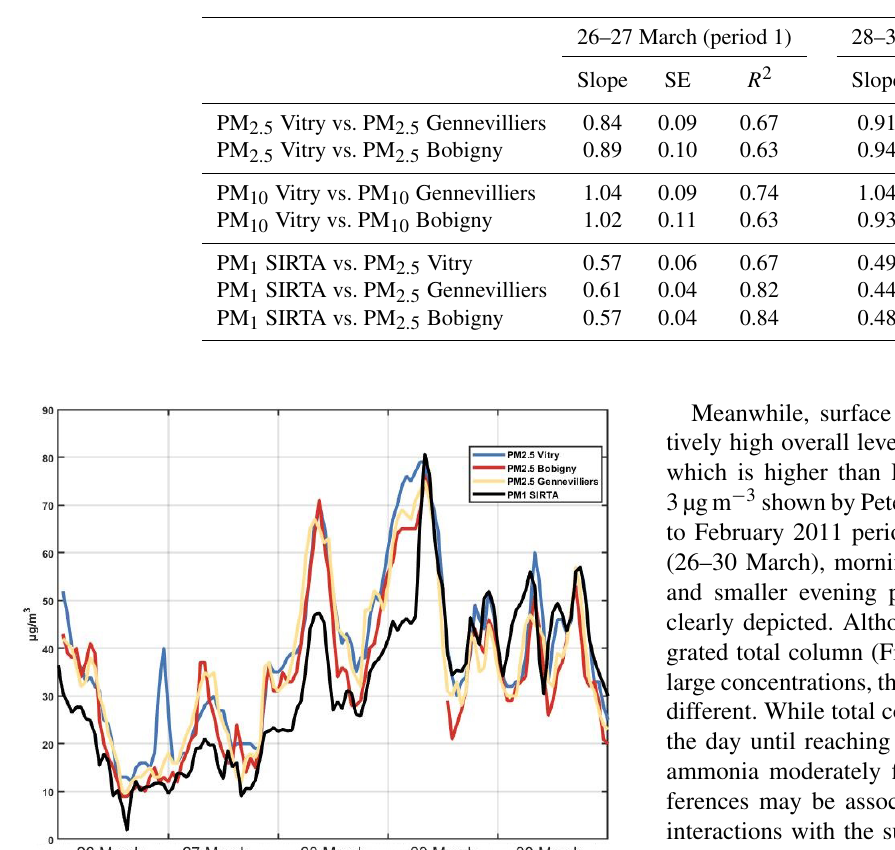
Table 1. Correlation of different available PM values of Vitry, Gennevilliers, Bobigny and SIRTA sites during 26–27 March (period 1) and 28–30 March (period 2). SE refers to standard error, and R 2 refers to the square of the correlation coefficient.